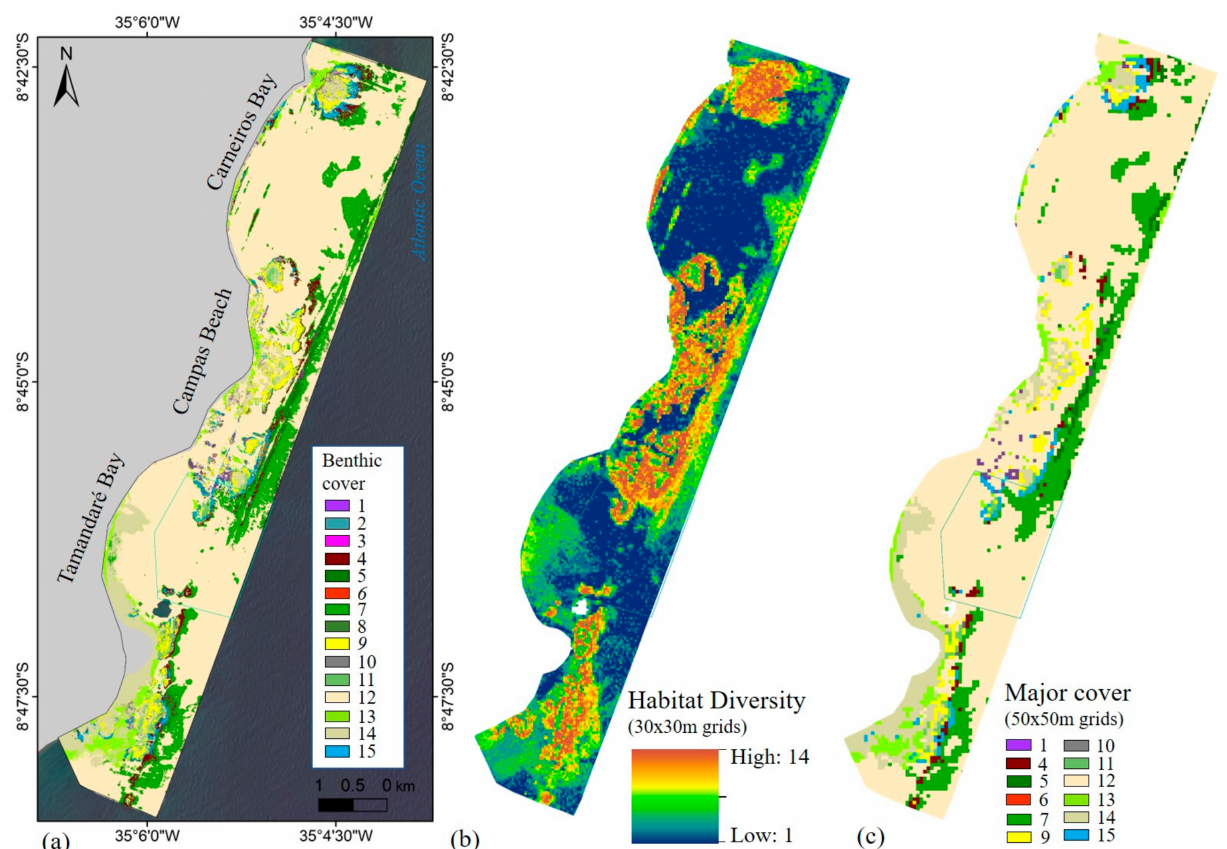
Figure 6. Ecological layers used as environmental variables in the predictive modeling of Millepora alcicornis . The hollow blue polygon on the three images shows the location of the no-take zone. ( a ) Habitat map of the coastal reefs of Tamandar é , Pernambuco, with 15 classes: (1) reef rubble, (2) rock/algae and urchin, (3) rock/coral and urchin, (4) fore-reef/“Itapitangas”, (5) macroalgae, (6) Millepora alcicornis , (7) algae turf (leafy), (8) macroalgae and seagrass, (9) Palythoa caribaeorum , (10) reef flat - hard substratum, (11) reef flat with algae, (12) sand, (13) seagrass, (14) terrigenous sediment and (15) calcareous mat. ( b ) Number of different habitats present in a 30 × 30 m grid, or 900 m 2 area. ( c ) Major benthic cover calculated for a 50 × 50 m grid, or 2500 m 2 area. Table 3. Benthic habitats identified in the habitat mapping of Tamandar é coastal area. Habitat classification is given following the scheme proposed in [84]. Main cover of each benthic habitat was identified in CPCe software using 15 points per photo and is displayed in order of contribution.